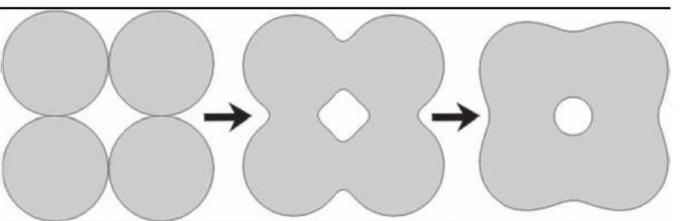
Figure 4. A schematic diagram representing the changes occurring with spherical particles under sintering. Shrinkage is noticeable.